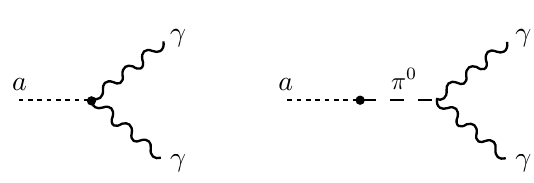
Figure 7 . Leading-order contributions to the a → γγ decay amplitude in the chiral expansion. The π 0 γγ coupling is obtained from the Wess-Zumino-Witten term not shown explicitly in (7.7).